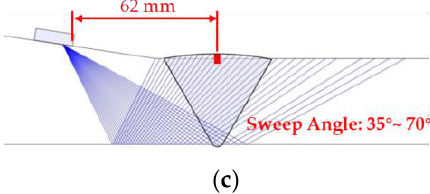
Figure 7. Scan plan drawing for simulation; ( a ) index offset 8 mm, sweep angle 35 – 75 ° assigned for the flange – elbow structure; ( b ) index offset 20 mm, sweep angle 35 – 70 ° assigned for tapered elbow structure; ( c ) index offset 62 mm, sweep angle 35 – 70 ° assigned for tapered upper structure.